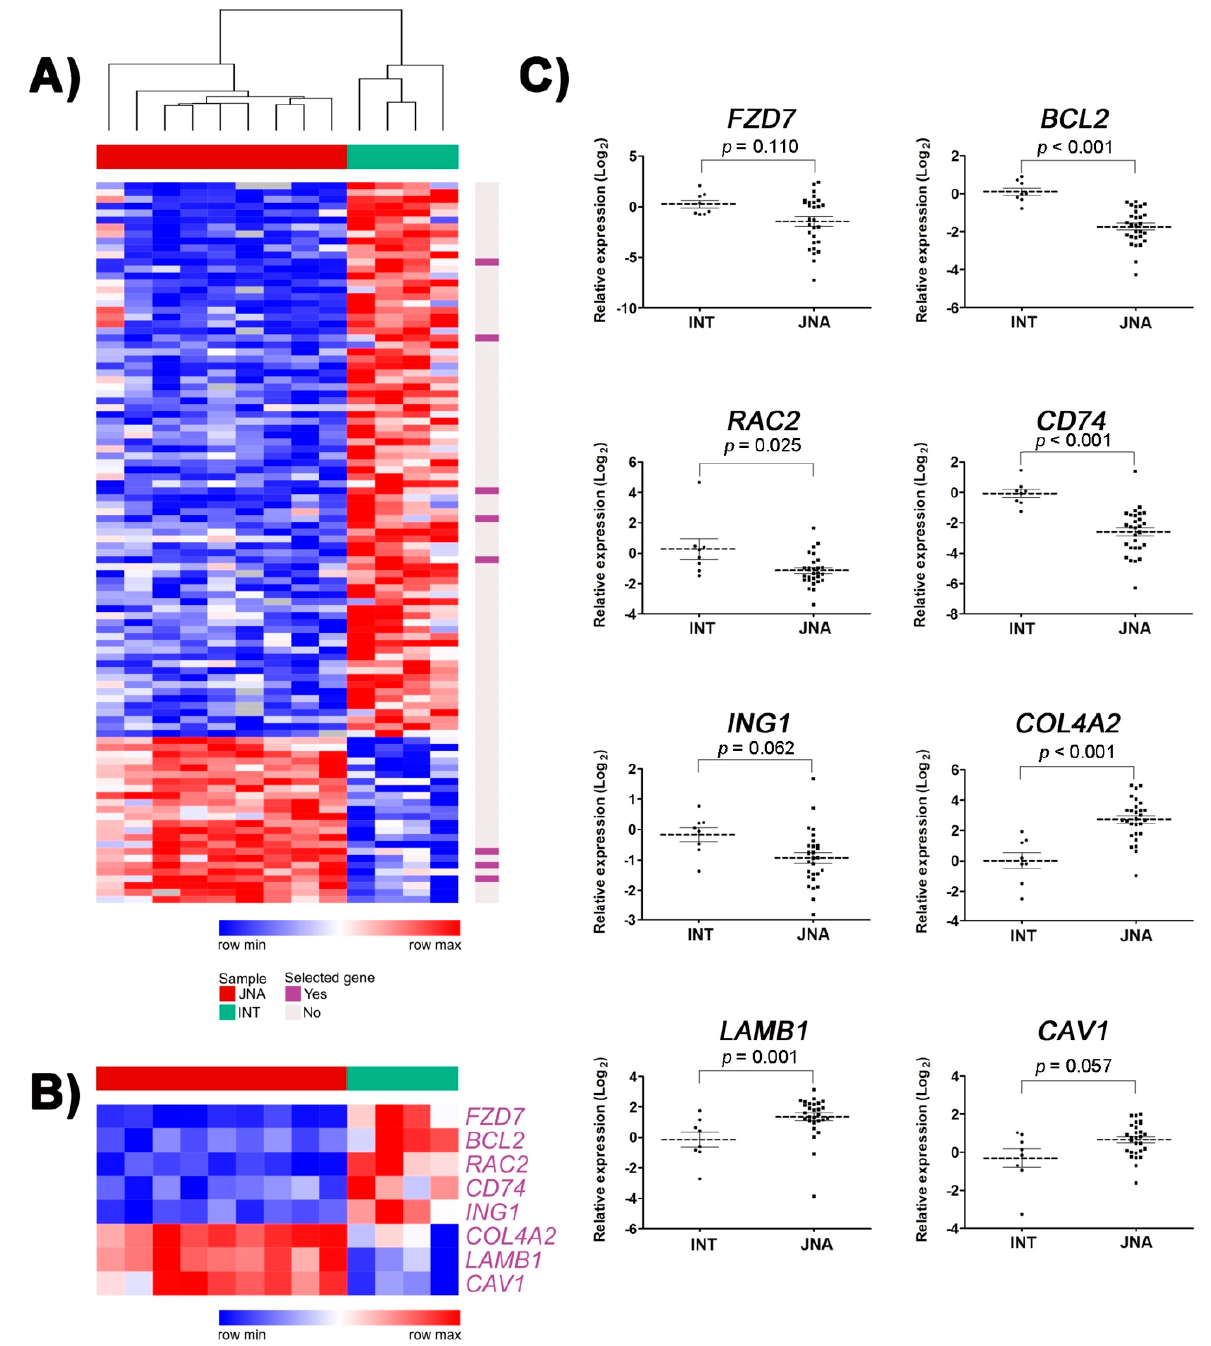
Figure 1. Gene expression analysis in juvenile nasopharyngeal angiofibroma (JNA): ( A ) heatmap and dendogram based on the expression levels of the 104 differentially expressed genes (DEGs) identified by cDNA microarray. Hierarchical clustering was performed assuming Euclidean distance. The top bar identifies JNA (dark red) and inferior nasal turbinate (INT; green) samples, and rows represent genes. Red and blue represent increased and decreased expression, respectively. White indicates no change in expression level compared with the reference sample and gray indicates that no intensity was detected; ( B ) among these DEGs, eight (purple) were evaluated by RT ‐ qPCR and/or immunohistochemistry; ( C ) dot plot showing the normalized relative expression levels from the INT ( n = 8) and JNA ( n = 28) samples assessed by RT ‐ qPCR. p ‐ value was determined by the Mann–Whitney test.